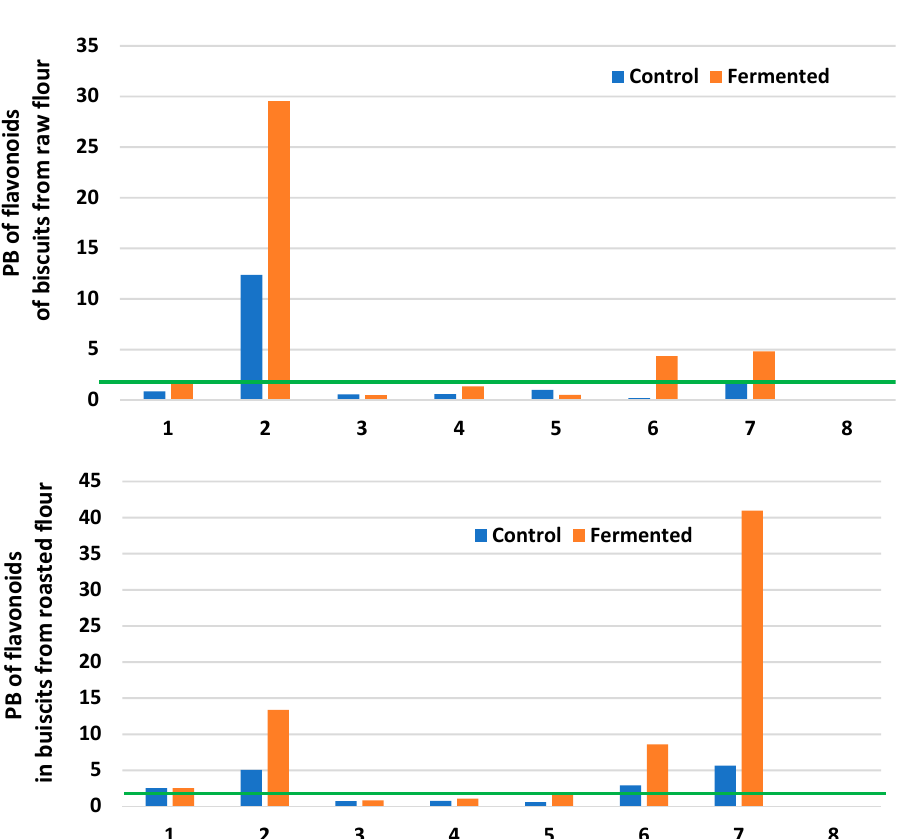
Data expressed as mean ± standard deviation ( n = 3). DM: dry matter. PB—potential bioaccessibility. Values followed by the same letter in the same column (a,b) or raw (A–C) are not significantly different at a 95% confidence level. * data were presented by Zieli´nski et al. [10].